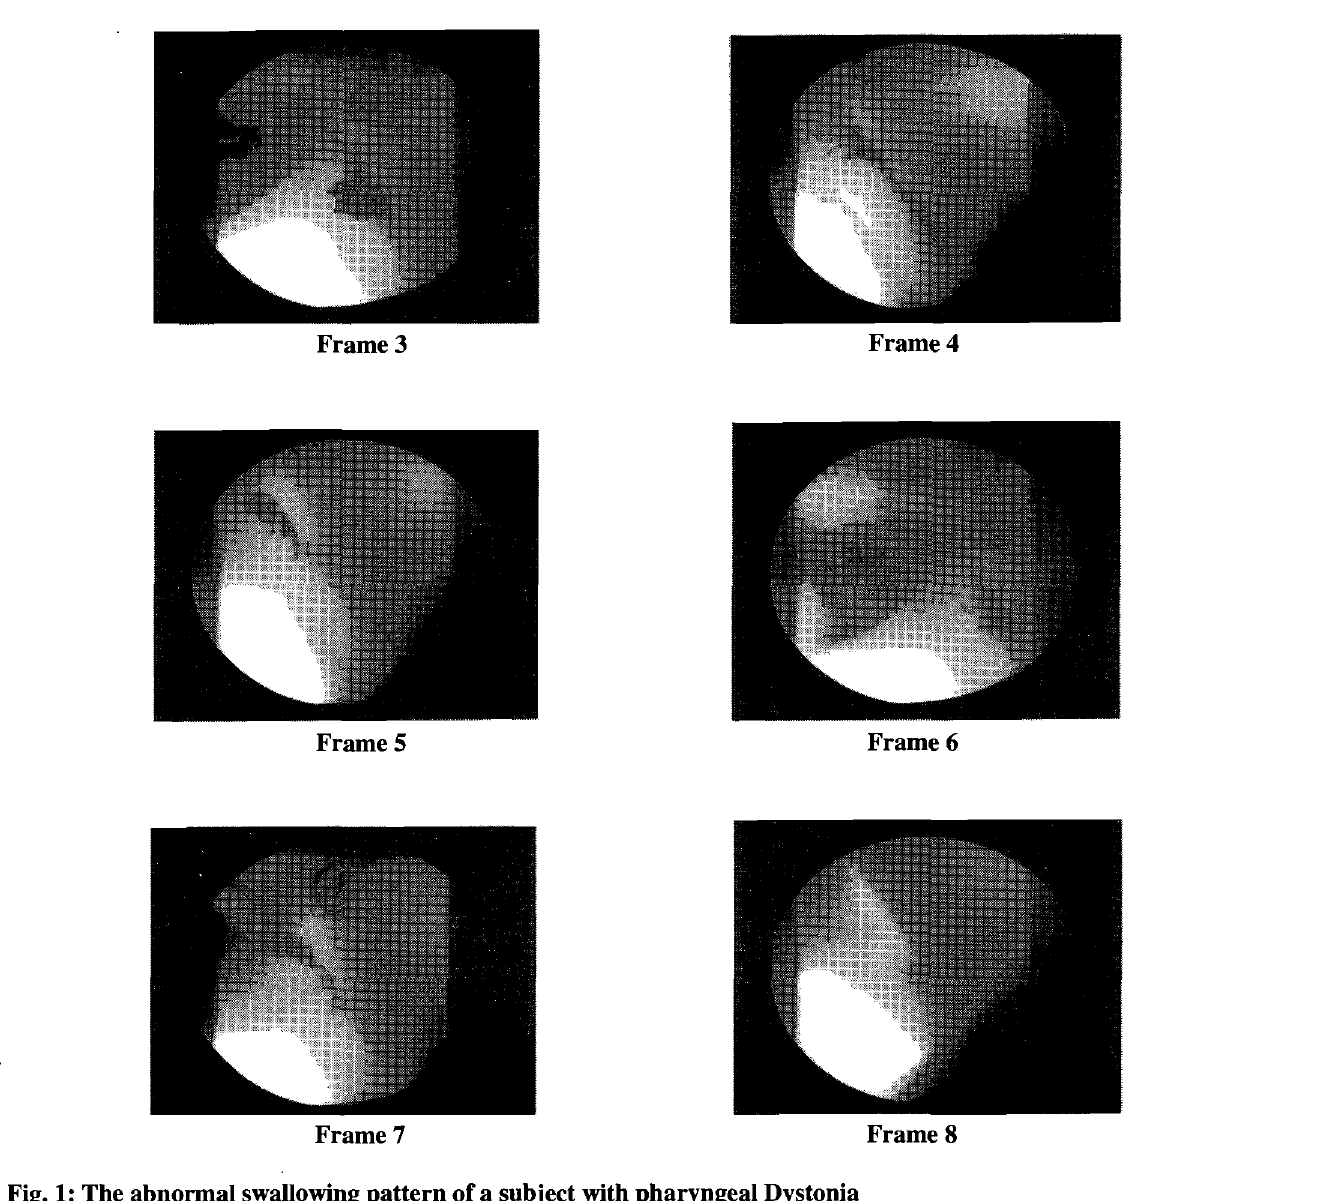
Fig. 1: The abnormal swallowing pattern of a subject with pharyngeal